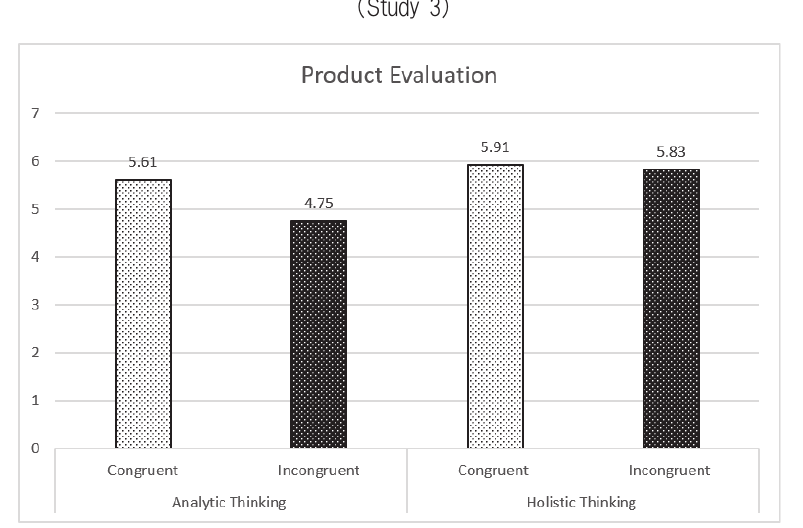
<Figure 4> The Interaction Effect of Thinking Style and Goal Congruence on the Evaluation of New Products